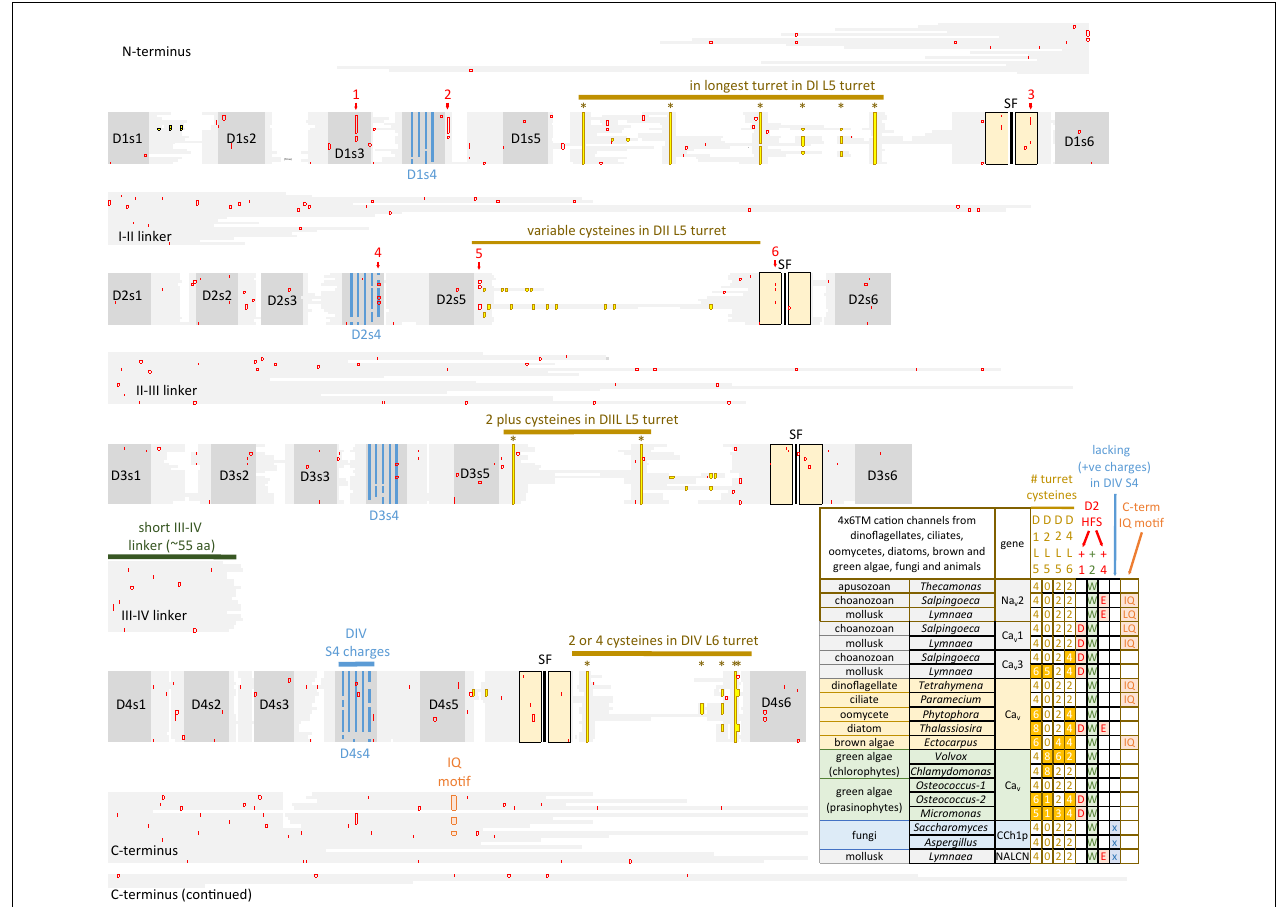
FIGURE 7 | Alignment of 4 × 6 TM cation channel representatives illustrating a shared fundamental architecture of asymmetrically arranged extracellular and intracellular regions from single cell protists (choanoflagellates, dinoflagellates, oomycetes, and ciliates), green algae (chlorophytes and prasinophytes), brown algae, yeast, and Na v 2, Na v 1, Ca v 1, Ca v 2, and Ca v 3 channels from protostome invertebrate (pond snail, L. stagnalis ). A concerted evolutionary change to a common asymmetrical architecture of 4 × 6 TM cation channels contrasts with the pseudo-symmetry of cyclic nucleotide-gated potassium channel (CNGK) channels which contain four nearly identical domains chained together. Long extensive extracellular turrets prior to the pore selectivity filter (SF) include L5 1 , L5 III and more rarely L5 II and a longer turret after the SF in L6 IV , as well as a 4-0-2-2 framework of core cysteines populating L5 I -L5 II -L5 III -L6 IV extracellular turrets in 4 × 6 TM channels. L5 IV extracellular turret is always short in 4 × 6 TM channels. The cytoplasmic III-IV linkers are always short ( ∼ 53–57 amino acids) compared in contrast to more variable I-II linker, II-III linkers, and N- and C-termini in 4 × 6 TM cation channels. Intron splice sites are indicated by red vertical lines. Dinoflagellate, ciliate, oomycete, diatom, green and brown algae channels illustrated in the figure all possess a conserved HFS site resembling an animal calcium channel (EEEE). Notably lacking in most of these protist channels is the conservation in the pore selectivity filter of Domain II of a “ calcium beacon ” aspartate (D) (HFS+1) omni-present in animal calcium channels, or a “ sodium beacon ” glutamate (HFS+4) omni-present in animal sodium channels, and a C-terminal IQ motif. A tryptophan ring at HFS+2 is present in all four domains of all channels except Domain I of Cch1p. A notable absence of S4 charges is found for yeast Cch1p and NALCN. Amino acid sequences were aligned using MUSCLE 3.7 (Edgar, 2004) within EMBL-EBI web interface (Chojnacki et al.,